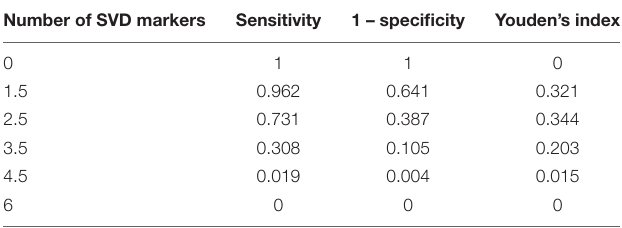
TABLE 4 | Optimal cutoff value of the number of cerebral small vascular disease (CSVD) markers predicting major adverse cardiac and cerebrovascular events (MACCE).